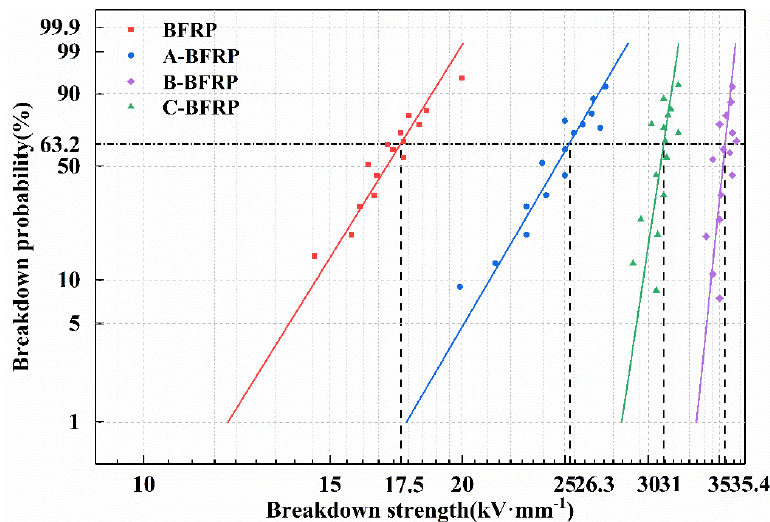
Figure 5. Breakdown strength of basalt fiber/epoxy resin